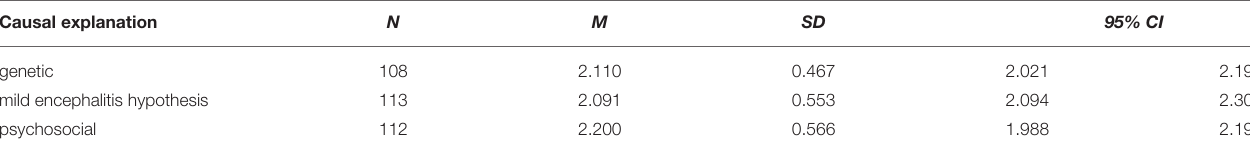
TABLE 2 | Descriptive statistics for the total mean social distance score as function of the causal explanation.